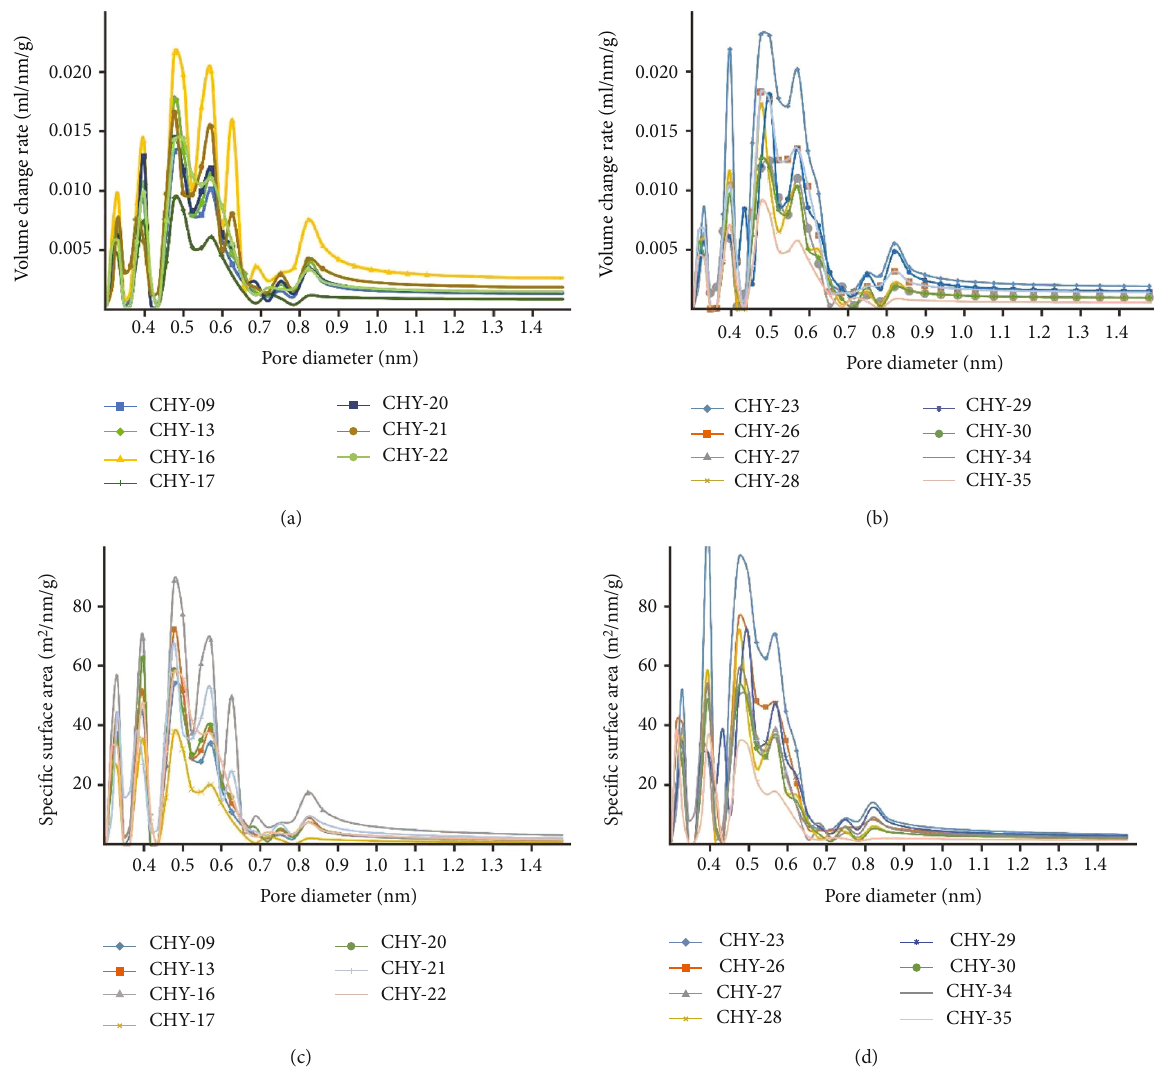
Figure 6: Pore volume and surface area variation of micropores with the pore